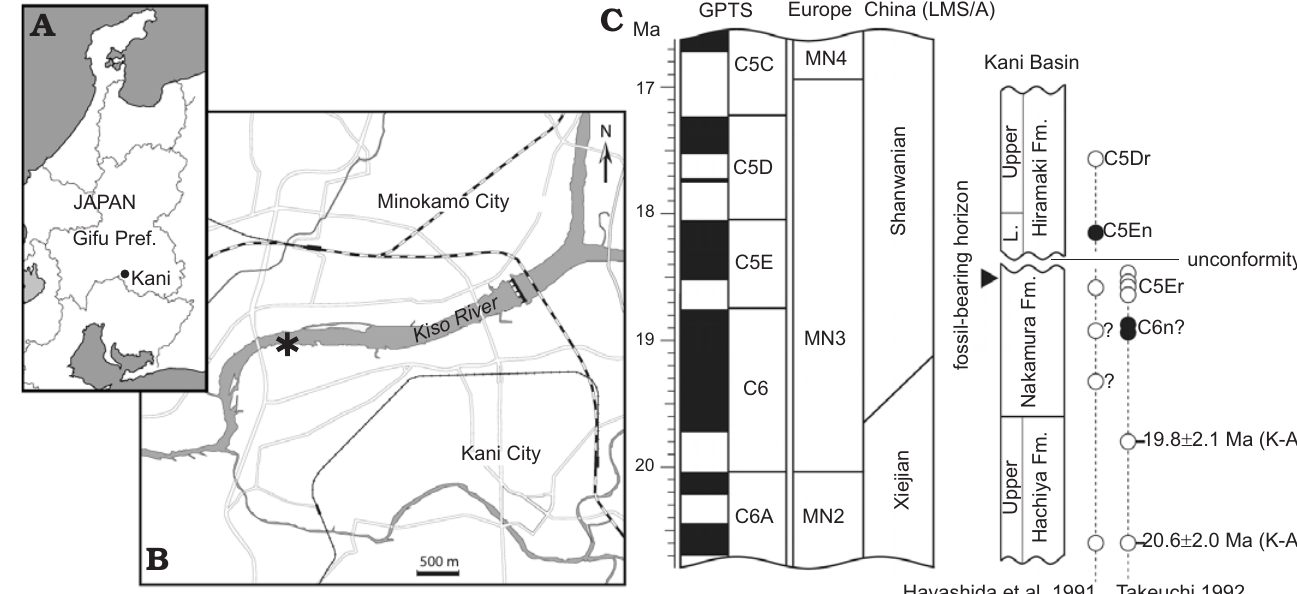
Fig. 1. Type locality and geologic age of Japaneomys yasunoi gen. et sp. nov. A , B . Location of Dota (asterisk) in Kani City, Gifu Prefecture, Japan (after Miyata and Tomida 2010). C . Stratigraphic position of the fossil bearing horizon and chronological relationship of the Miocene strata in Kani Basin (after Tomida et al. 2013). Absolute dates of the magnetozone boundaries follow Hilgen et al. (2012). The correlations of European MN zones and Chinese land mammal stage/age (LMS/A) follows Qiu et al. (2013). The black and white circles respectively indicate normal and reversed polarities of paleomagnetic samples from the sediments. Abbreviation: GPTS, Geomagnetic polarity timescale; L., Lower; Pref.,